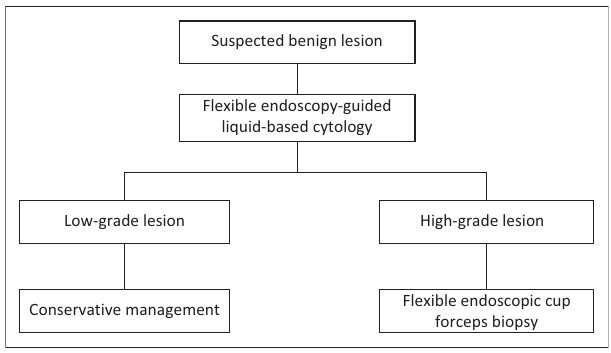
FIGURE 3: Algorithm for tissue sampling of suspected benign laryngopharyngeal lesions where dysplasia has to be